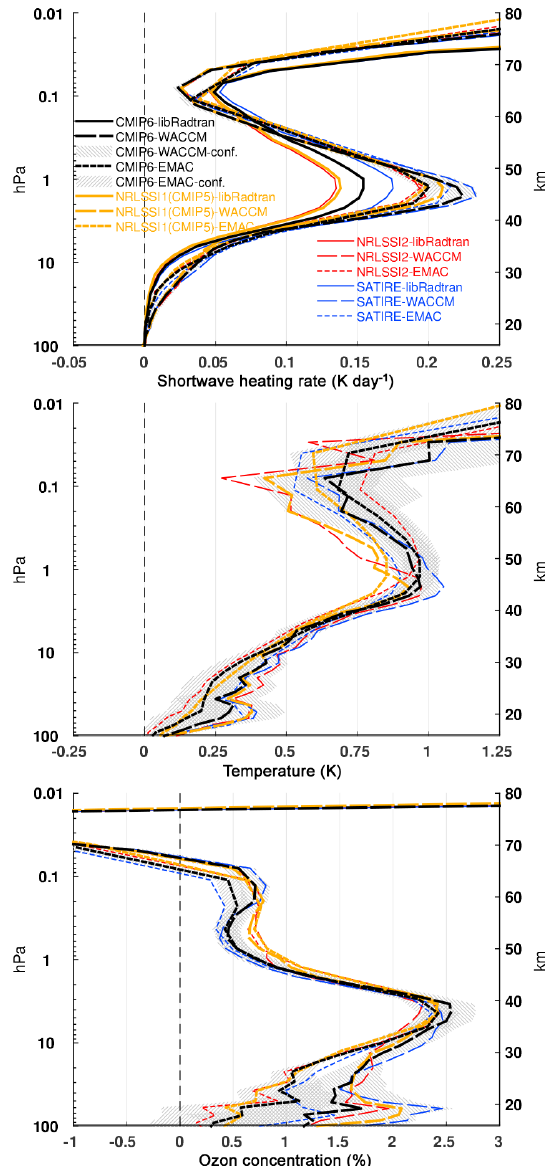
Figure 8. Impact of the 11-year solar cycle (differences between perpetual solar-maximum and solar-minimum experiments) on cli- matological (annual mean) profiles of shortwave heating rates (top), temperature (center), and ozone concentrations (bottom) averaged over the tropics (25 ◦ S–25 ◦ N) according to CMIP6 (black) and CMIP5 (yellow) solar forcing as well as NRLSSI2 (red) and SATIRE (blue) derived from simulations with CESM1(WACCM) (long-dashed), EMAC (short-dashed), and libradtran radiative transfer calculations (solid; only in the top panel); 95% confidence intervals for CMIP6 simulations (hatched) estimated by bootstrap-